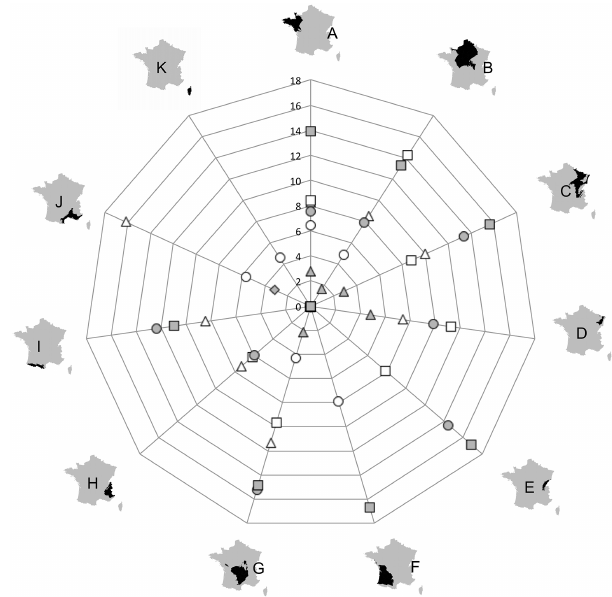
Figure 6. Root mean square error (RMSE) of tree diameter for dif- ferent species (shown as different markers) for different regions over France (shown as A to K). Open triangle, Pinus sylvestris ; open circle, Pinus pinaster ; open square, Picea Sp.; filled diamond, Quercus ilex/suber ; filled triangle, Betula Sp.; filled circle, Fagus sylvatica ; filled square, Quercus robur/petraea